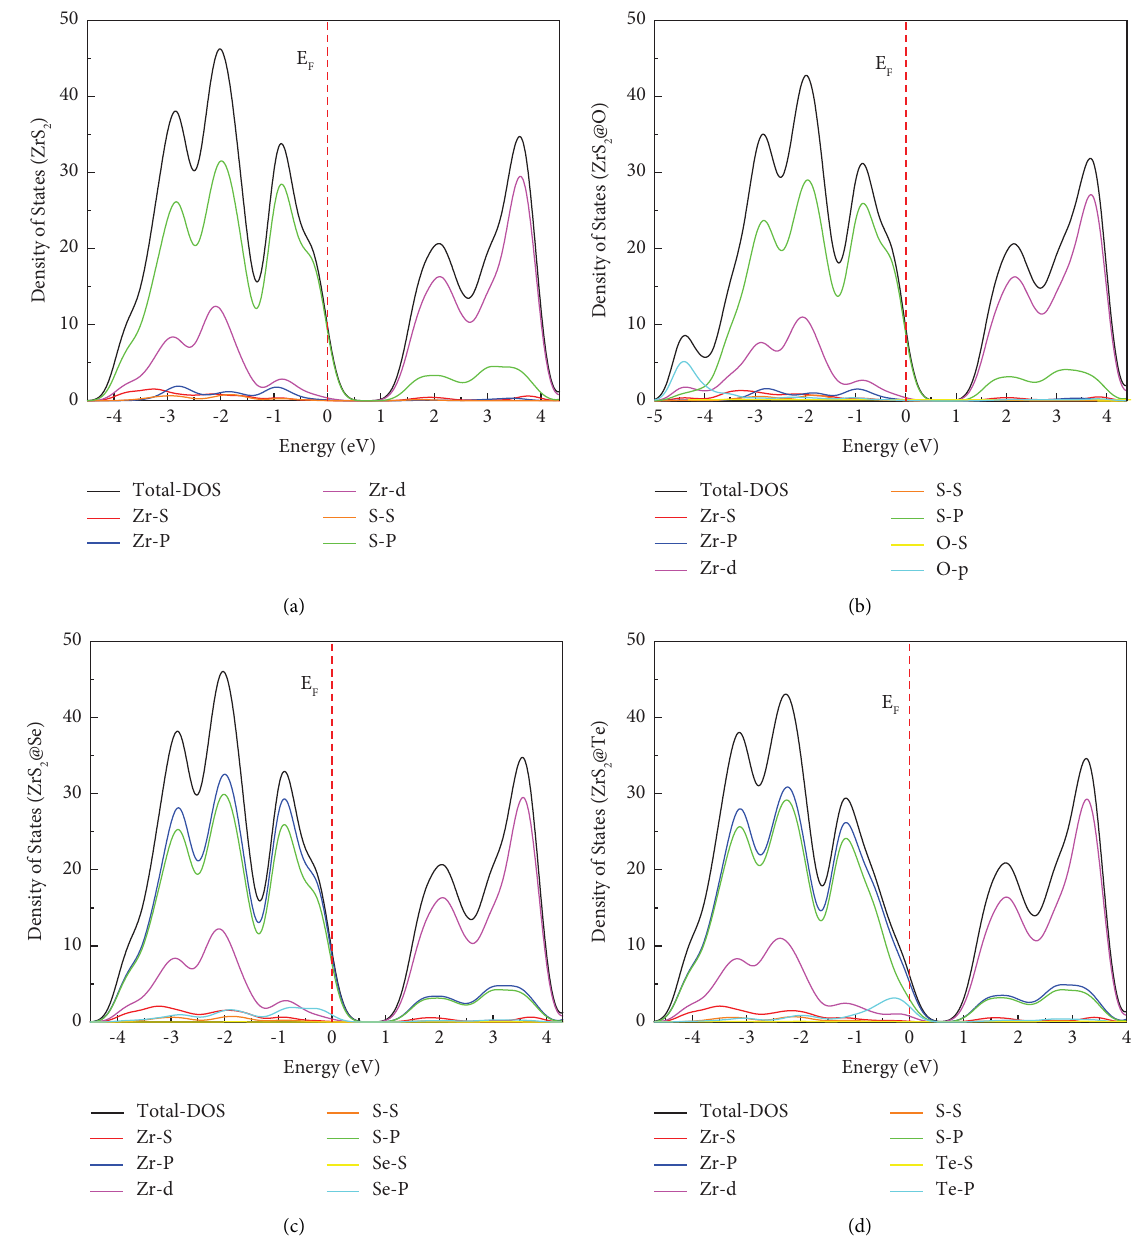
Figure 3: Te density of states of the pristine and single-doped ZrS Te-doped ZrS 2